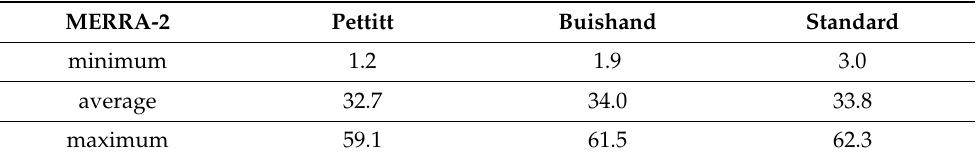
Table 7. Minimal, average and maximal share of explained discontinuities in percentage by the change in 2004 and in 2015 to all discontinuities from all months from MERRA-2 for the Pettitt test, the Buishand test and the Standard Normal Homogeneity test.